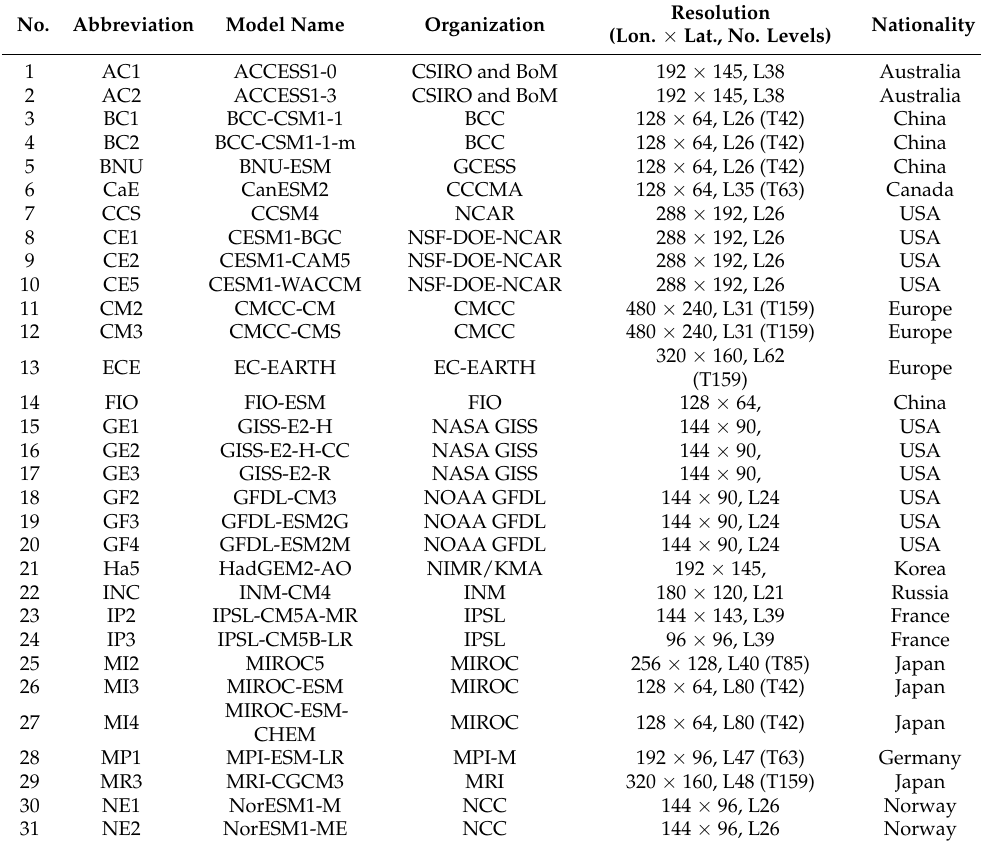
Table 2. List of the global climate models in CMIP5 used in this